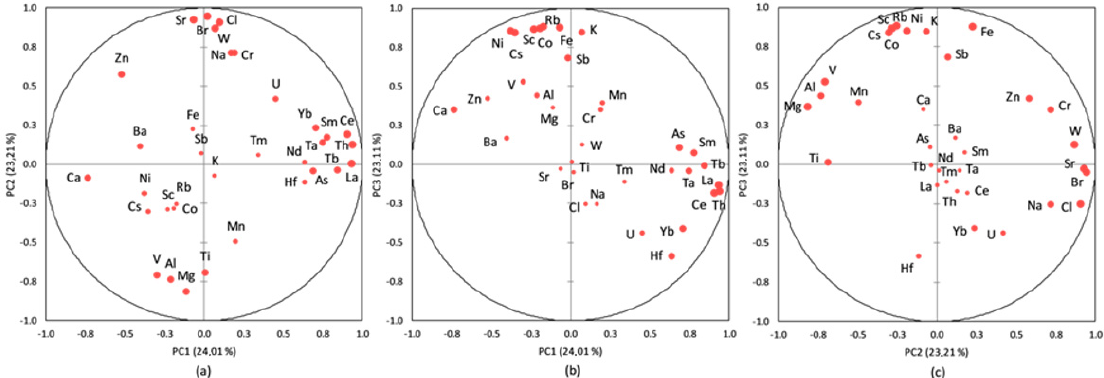
Figure 21. PCA box plots, PC1 versus PC2 ( a ), PC1 versus PC3 ( b ), and PC2 versus PC3 ( c ) obtained for quantified elements in sediment sample of Amara